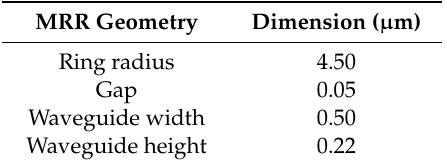
Table 2. The dimensions of the proposed microring resonator (MRR).